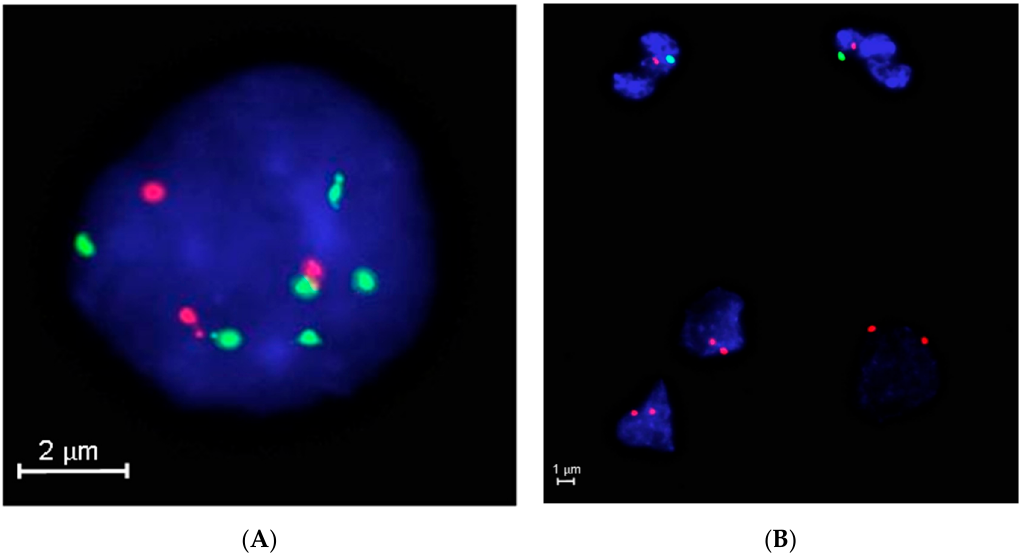
Figure 6. The Triple DNA FISH diagnostic assay on archived cytological samples of cFTC. ( A ) The six control green signals (1q25.3) and three red signals that are specific for 1p36.31 correspond to a loss of the 1p region (ZytoLight 1p36/1q25, ZytoVision, Bremerhaven, Germany). ( B ) The two red signals of the tumor cells show an X (red) gain and Y (green) loss next to normal granulocytes showing one red (X) and one green (Y) signal (male patient, Vysis CEP X/Y Abbott Laboratories, Abbott Park, IL, USA). Abbreviation: cFTC: classic follicular thyroid carcinoma.